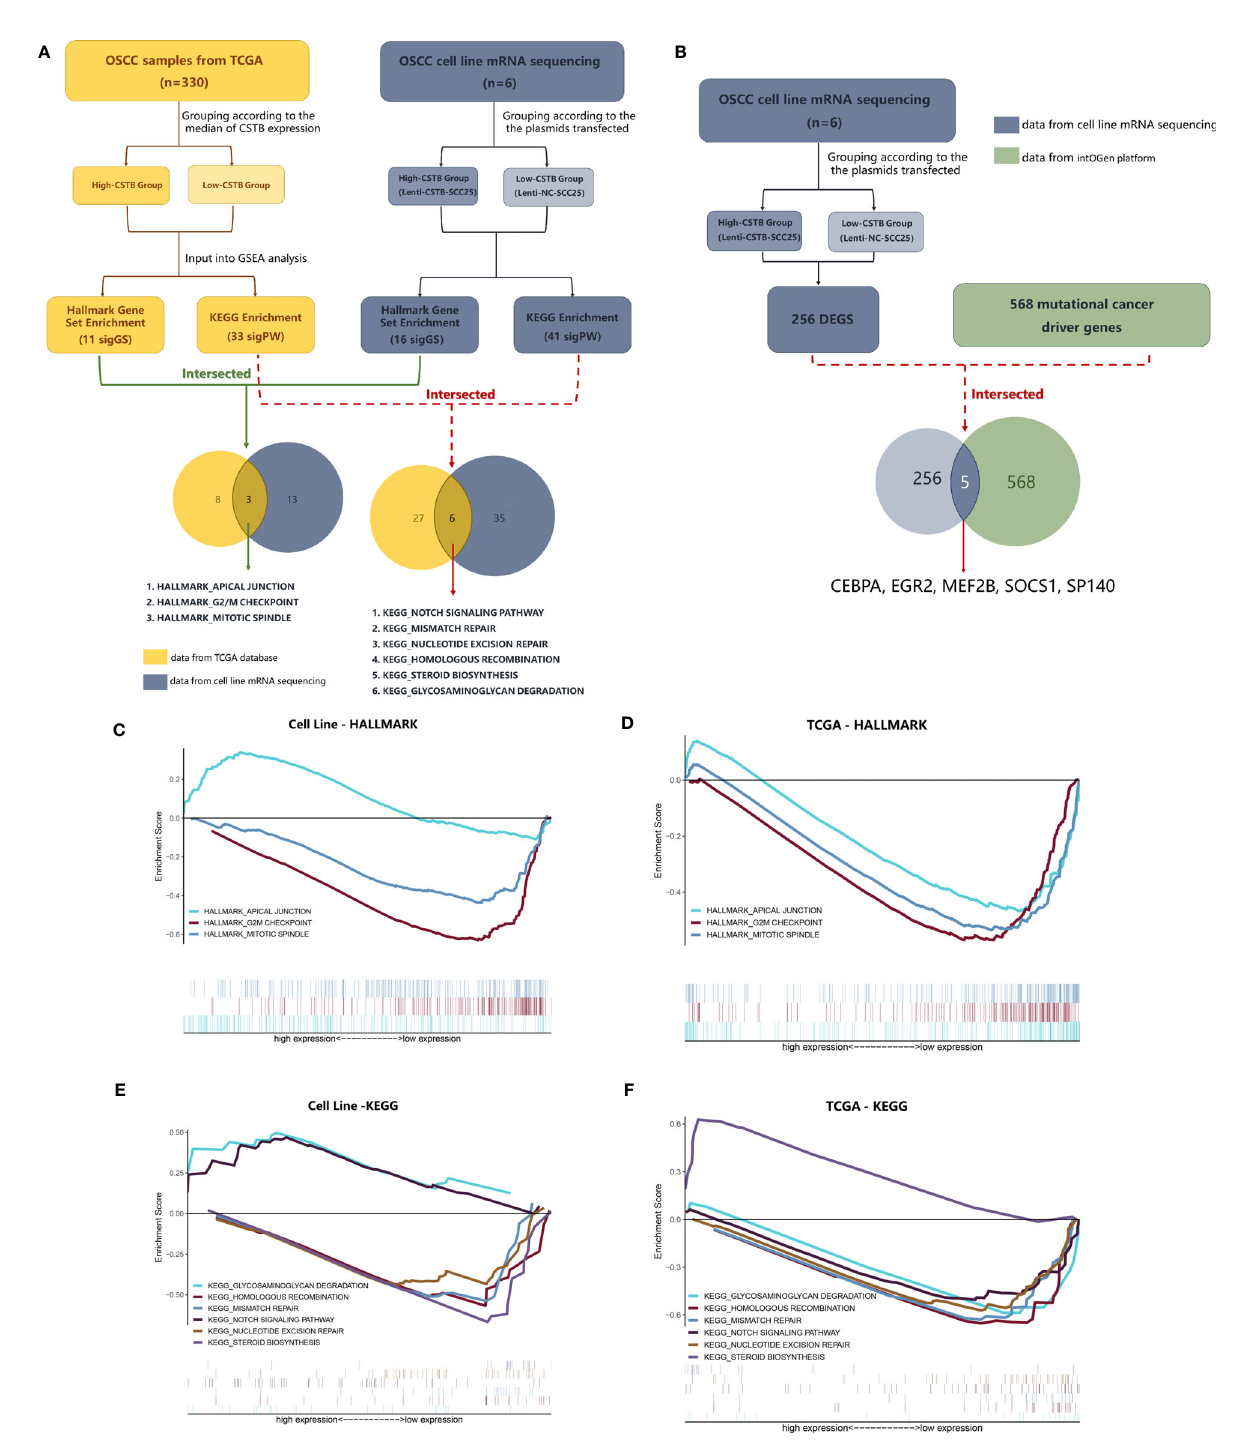
FIGURE 5 | CSTB may participate in OSCC through other tumor-related pathways. (A) The process and results of GSEA based on data from the TCGA database/ cell lines mRNA sequencing. (B) Comparison between mutational cancer driver genes and DEGs obtained from cell line mRNA sequencing. (C, D) GSEA using Hallmark gene sets. Gene sets with statistically signi fi cant differences based on data from the TCGA database/cell line mRNA sequencing. (E, F) GSEA using KEGG enrichment analysis. Pathways with both statistically signi fi cant differences based on data from the TCGA database/cell line mRNA sequencing.